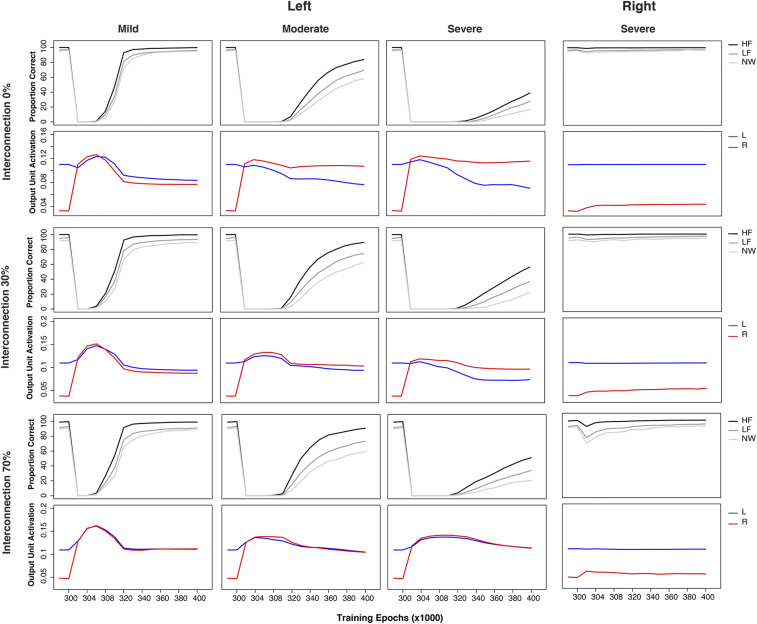
Simulation patterns of poststroke aphasia and recovery produced by the model with three levels of interconnections (0%, 30%, and 70%) between left and right sides for the left mild (20% [0.2]), left moderate (50% [0.5]), left severe (80% [0.8]), and right severe (80% [0.8]) lesion conditions. The lesion level was a combination of the proportion (percent) of the units that was damaged and the range of noise (bracket) added to the connections to and from the hidden layer. For each lesion and interconnection conditions, Top shows model performance and Bottom shows output unit activation generated from the left and right pathway of the model separately. HF, high-frequency words; LF, low-frequency words; NW, nonwords; L, left; R: right.